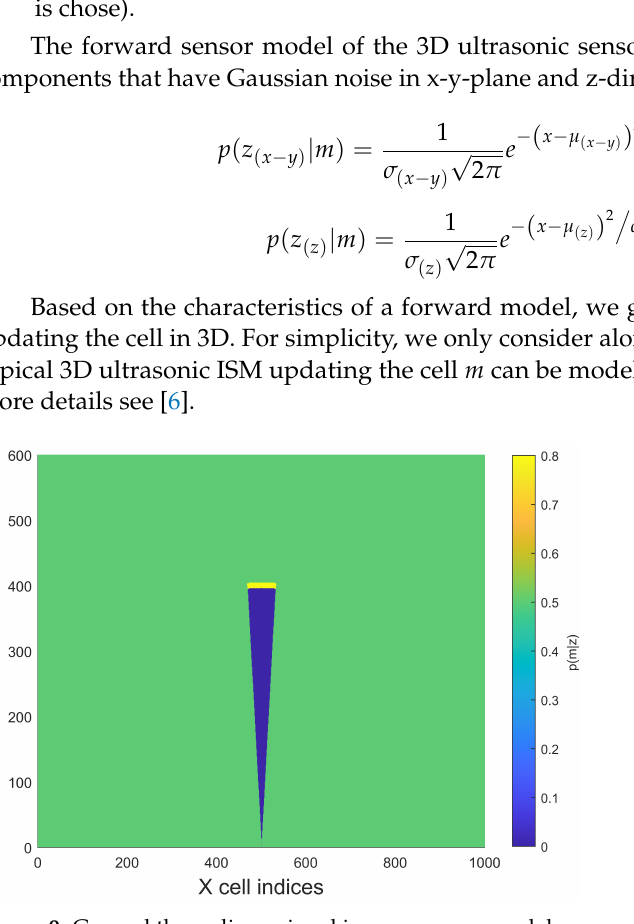
Figure 9. General three-dimensional inverse sensor model.